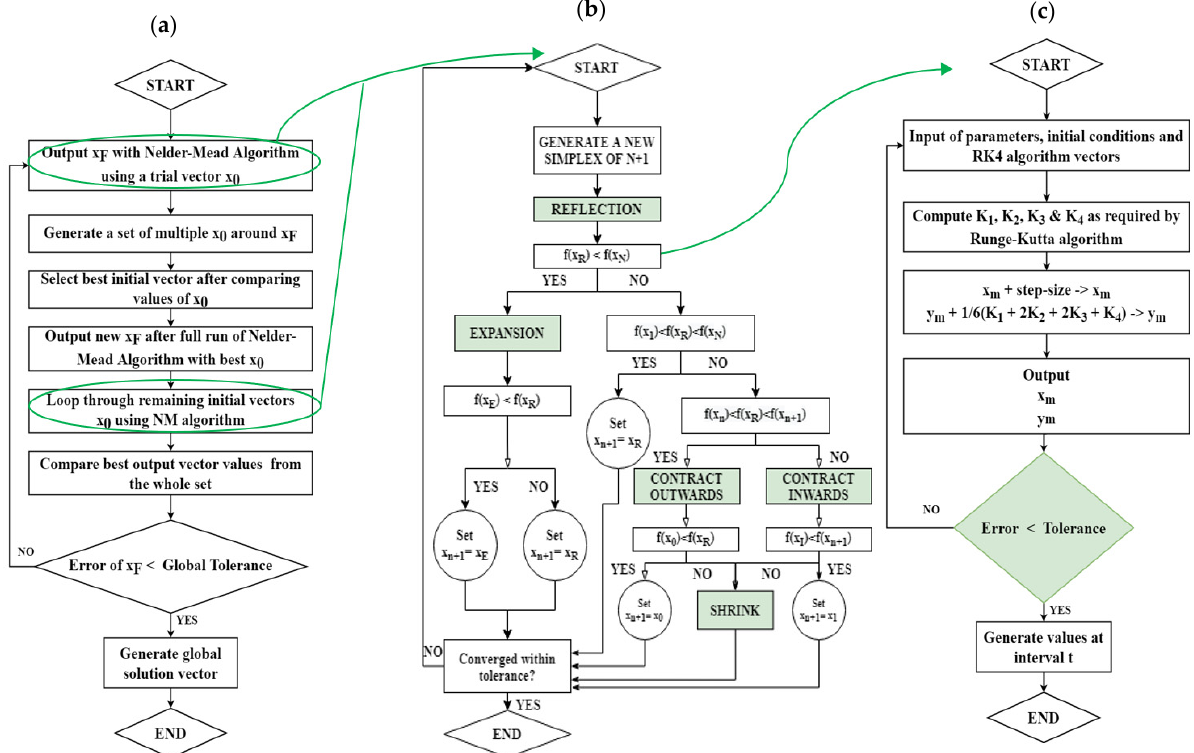
Figure 1. Algorithms for ( a ) Global search, ( b ) NM, and ( c ) RK4.